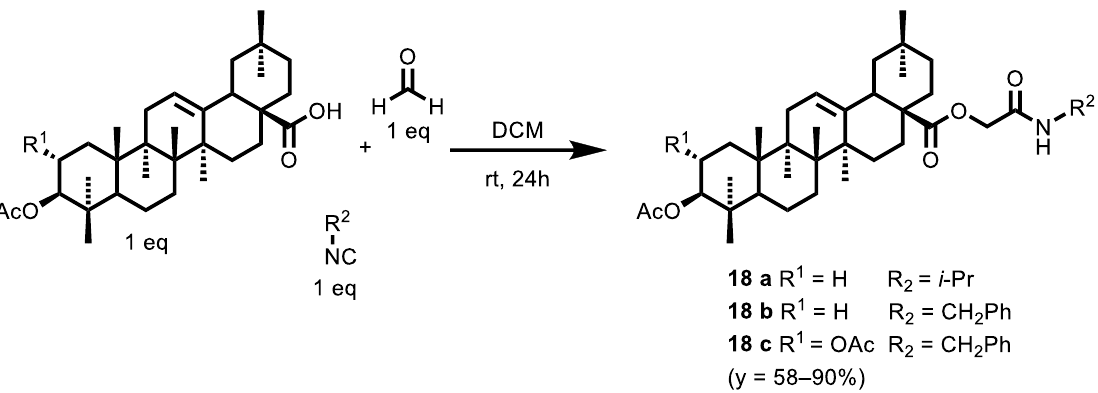
Scheme 6. Passerini products from natural triterpenoids: oleanolic acid (OA) and maslinic acid